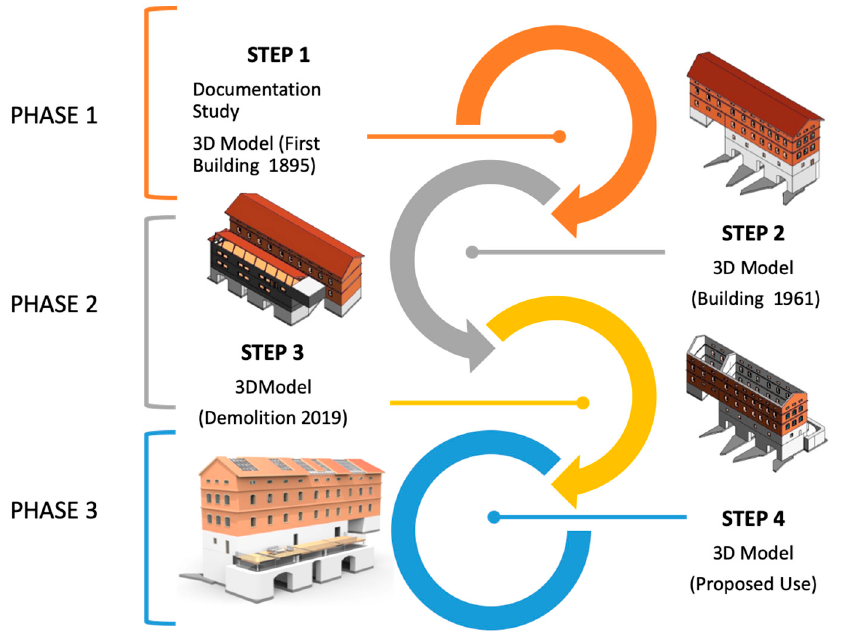
Figure 2. Phases and steps proposed in the real estate rehabilitation of an industrial heritage site using BIM for the case study